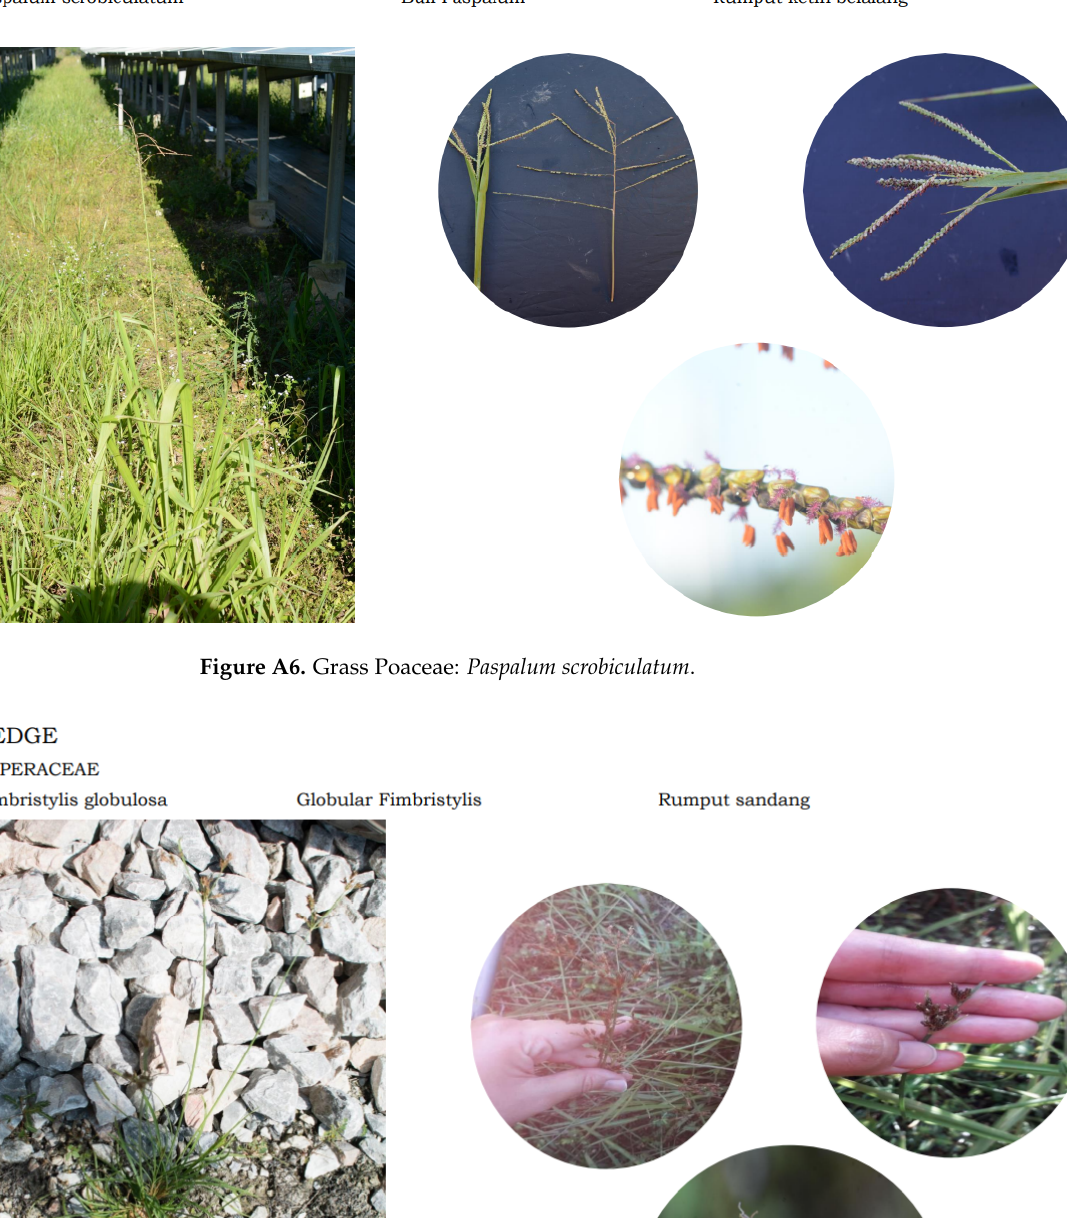
Figure A5. Herb Euphorbiaceae: Phyllantus amarus.